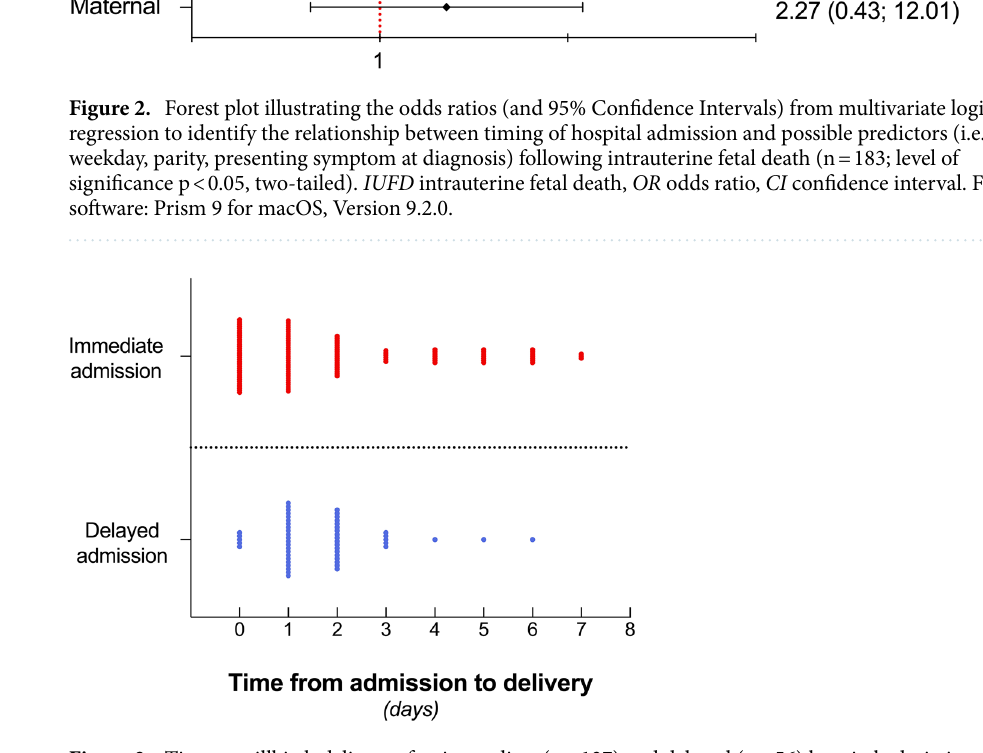
Figure 3. Time to stillbirth delivery after immediate (n = 127) and delayed (n = 56) hospital admission (nested scatter dot plot; width of distribution of points proportional to the number of delivered women; Day 0 = hospital admission day). Stillbirth delivery occurred in 20.8% (38/183) on Day 0 ; in 30.1% (55/183) on Day 1 , and in 20.2% (37/183) on Day 3 . Figure software: Prism 9 for macOS, Version